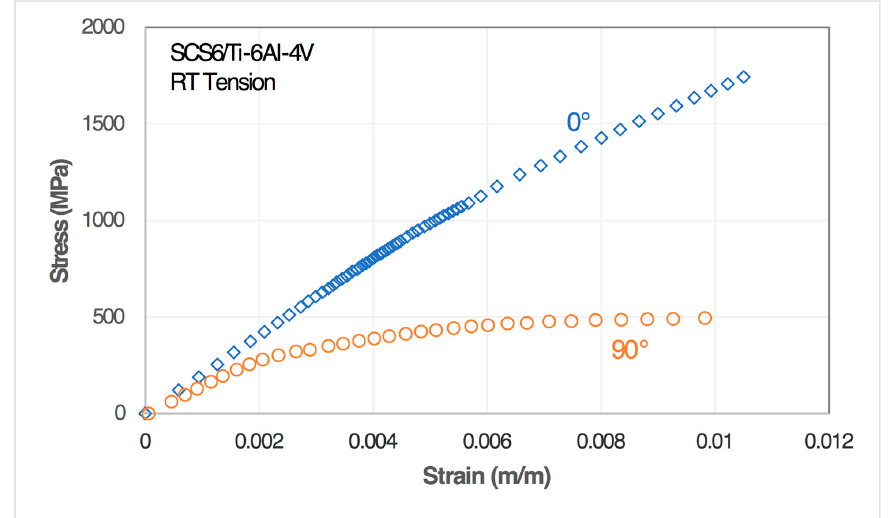
Figure 3. Uniaxial stress-strain curves for Ti-6Al-4V matrix material.